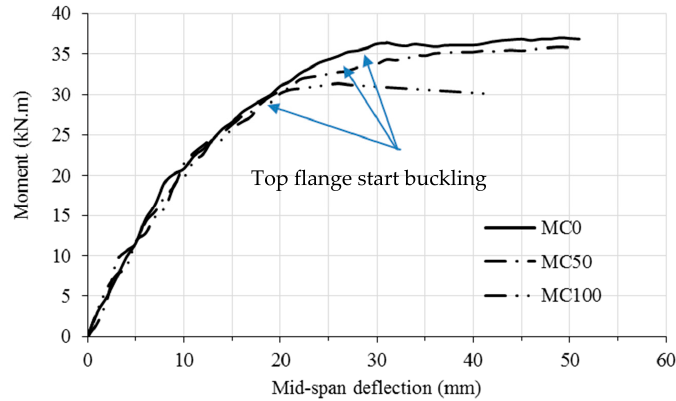
Figure 11. Moment vs. mid-span deflection relationships of the tested RCFSST specimens.